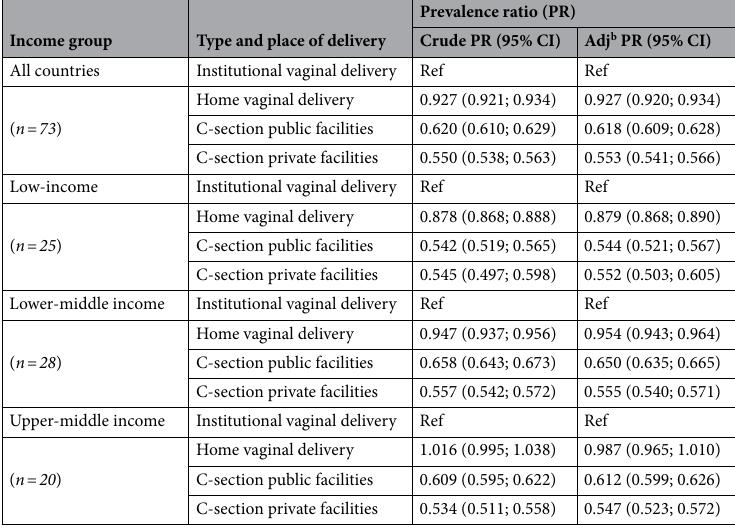
Table 2. Crude and adjusted prevalence ratios of early initiation of breastfeeding stratified by type of delivery and place of birth according to income group for 73 countries from LMICs. Household health surveys a , 2010– 2019. a Multiple Indicator Cluster Survey, Demographic Health Survey and National Health and Nutrition Survey (Ecuador). b Adjusted for place of residence, maternal age, maternal formal education, wealth quintiles. C-section cesarean section; CI confidence